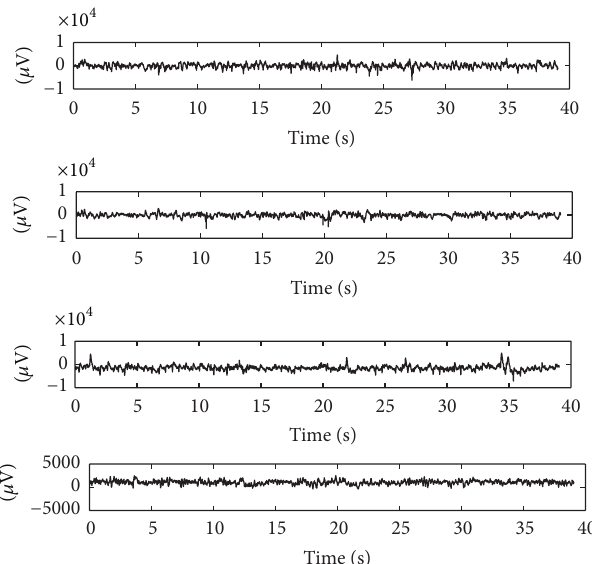
Figure 3: Examples of epileptic EEG segments from patients 1 and 3 of Freiburg dataset. From top to bottom: interictal EEG of patient 1, interictal EEG of patient 3, ictal EEG of patient 1, and ictal EEG of patient